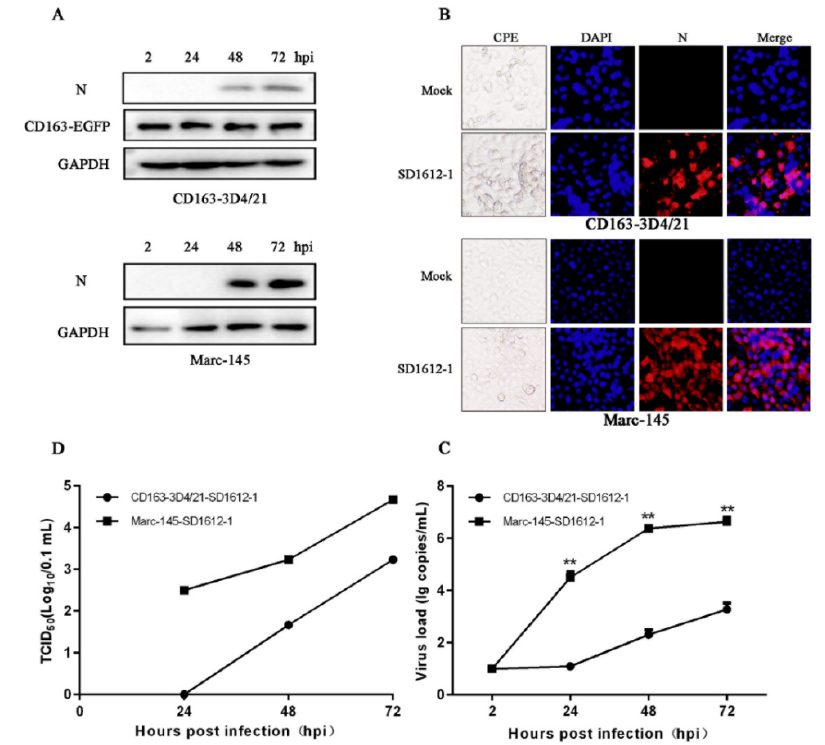
Figure 3. Growth of classical PRRSV2 strain SD1612-1 (lineage 8) on 3D4/21 cells stably expressing porcine CD163. ( A ) CD163-3D4/21 cells and MARC-145 cells seeded in 24-well plates were infected with PRRSV SD1612-1 at an MOI of 0.1, for the indicated time points, followed by Western blotting. ( B ) The infected cells were observed for PRRSV specific CPEs and fixed at 48 hpi followed by IFA using N mouse mAb (15A1). ( C , D ) The ORF7 transcriptions and viral titers of PRRSV SD1612-1 in CD163-3D4/21 cells and MARC-145 cells within 72 hpi were determined by SYBR Green real-time RT-PCR ( C ) and TCID50 assay ( D ), respectively. ** p < 0.01.